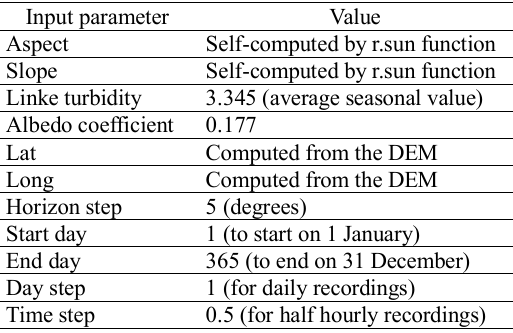
Table 2. GRASS r.sun.daily parameter